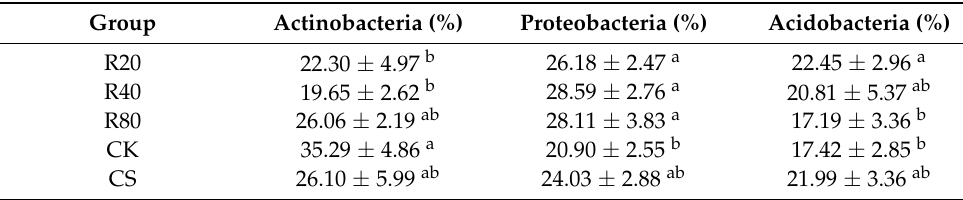
Table 4. Relative abundances of the three dominant phyla in the five groups of soils. Group